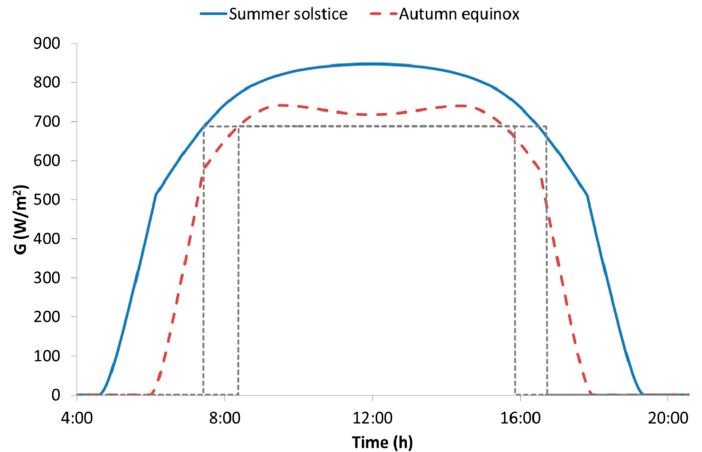
Figure 6. Incident irradiance profile on the tracker during the autumn equinox and the summer solstice.